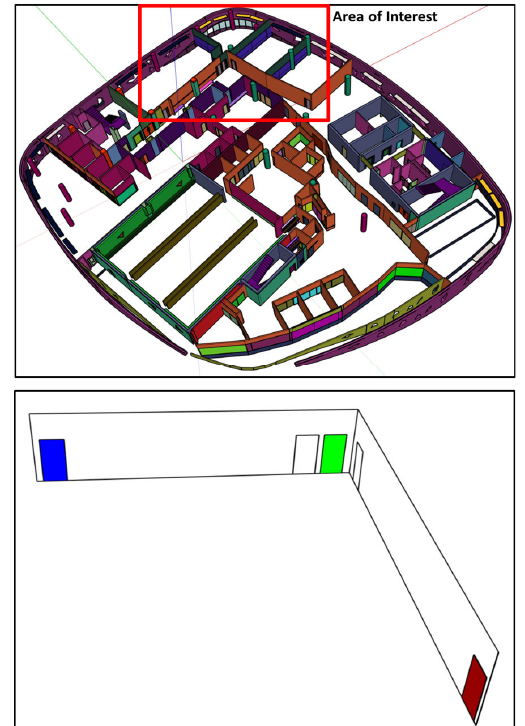
Figure 11: Top) The 3D indoor model of the second floor in the Bergeron Centre. The area of interest of the second experiment is outlined by the red box. Bottom) The 3D wireframe model used in the second